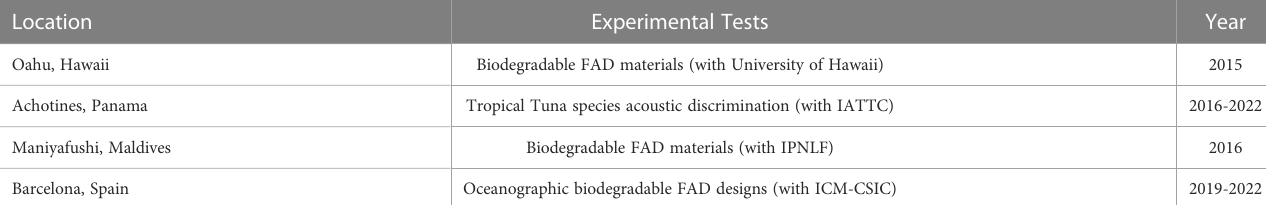
TABLE 5 ISSF-related FAD impact mitigation research activities conducted in near-shore facilities in collaboration with other scienti fi c institutions. Location